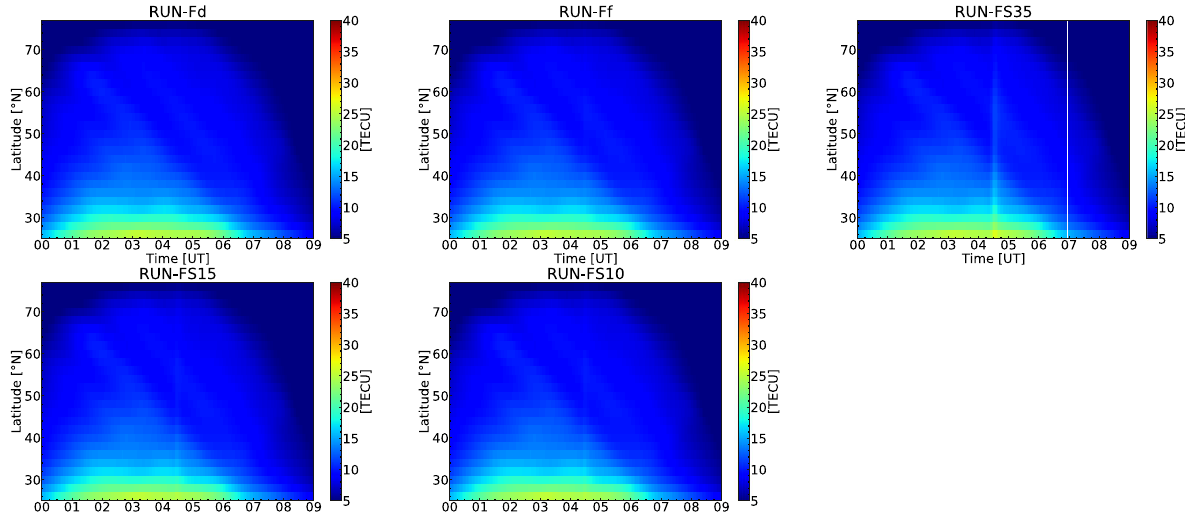
Fig. 3 TEC simulated by GAIA model. The TEC distributions for RUN-Fd, RUN-Ff, RUN-FS35, RUN-FS15, and RUN-FS10 at 130°E, where, locally, at the time of the flare are around noon for the X1.1-class flare on November 8,